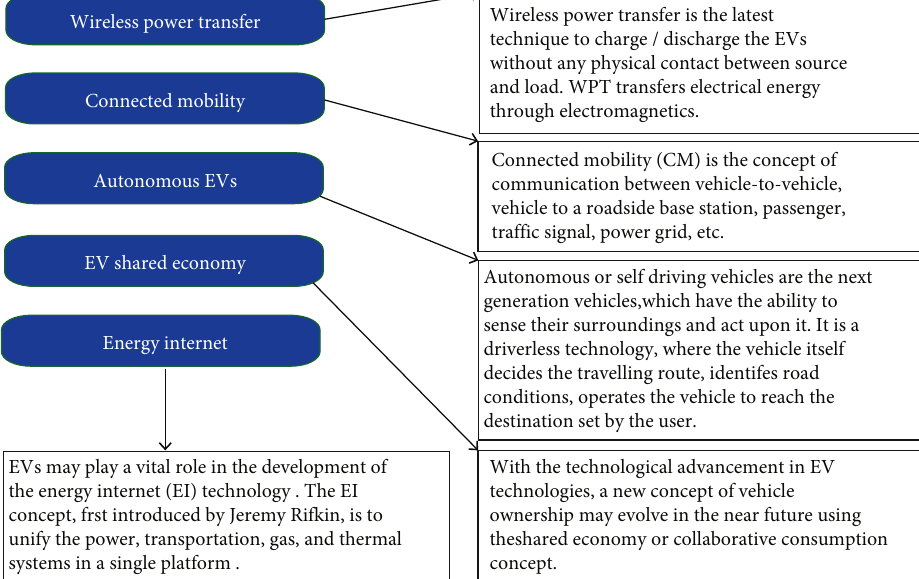
Figure 4: Classi fi cation of EV